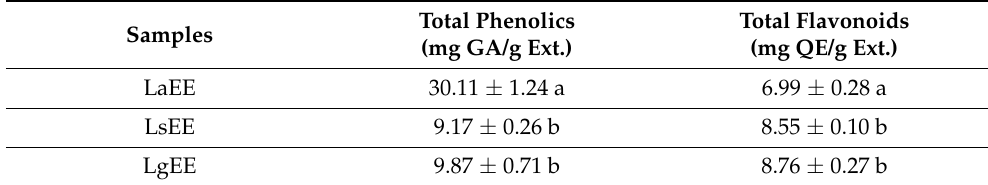
Table 2. Total content of phenols and flavonoids in the ethanolic extracts of L. alba , L. sidoides , and L. gracilis .